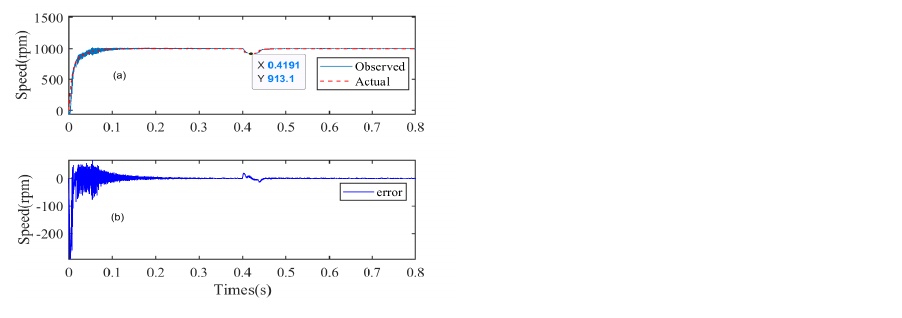
Figure A2. The speed response of VPDPI regulator when R s = 0.021 and J = 0.0008. ( a ) Observed speed and actual speed. ( b ) Estimation error curve